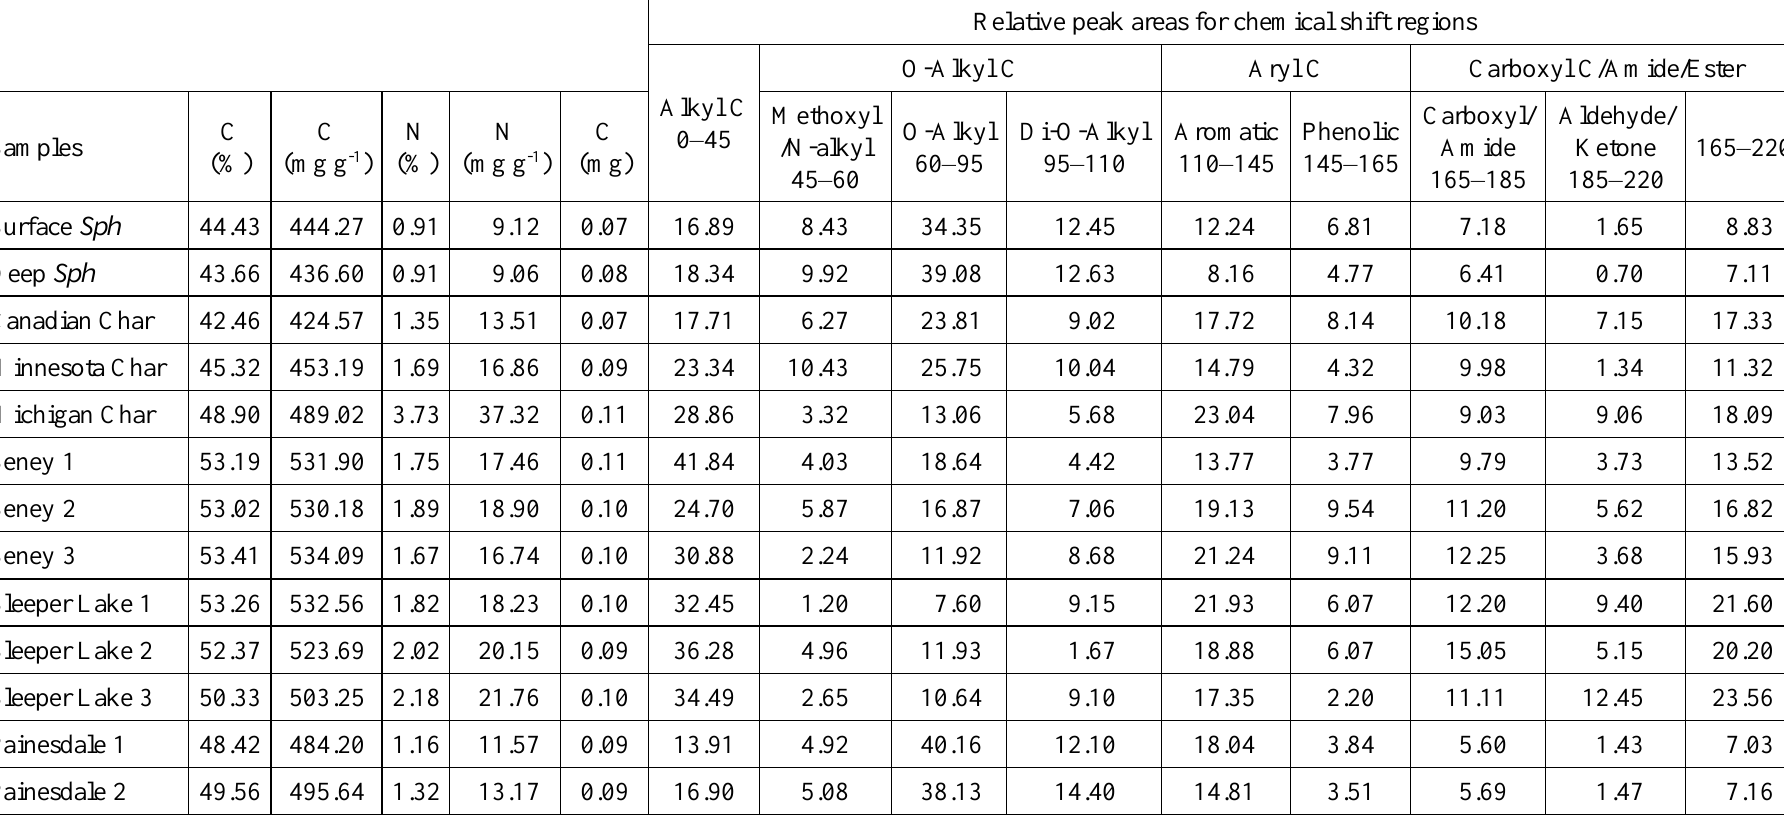
Table A3. Elaboration upon Table A2, providing additional data on direct polarisation NMR chemical shift regions, and on C and N concentrations. Relative peak areas for chemical shift